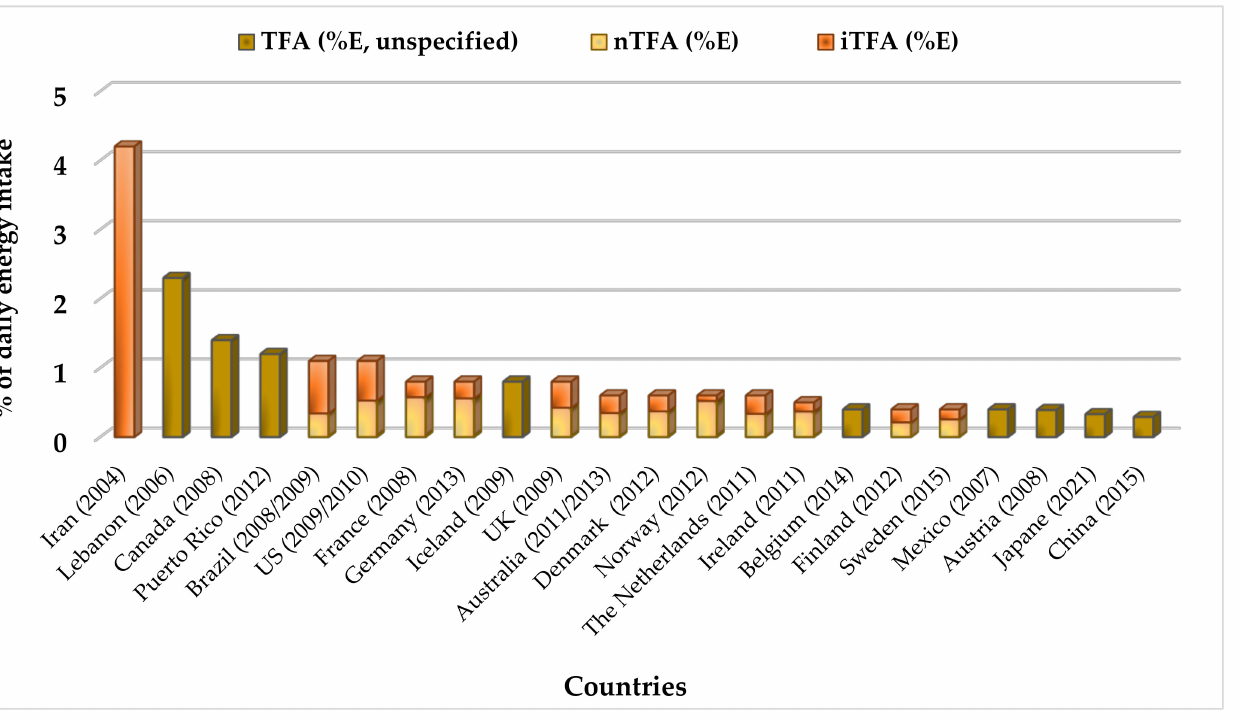
Figure 3. Mean intake of TFA as % of daily energy intake in different countries. The red line shows the maximum intake recommended by the